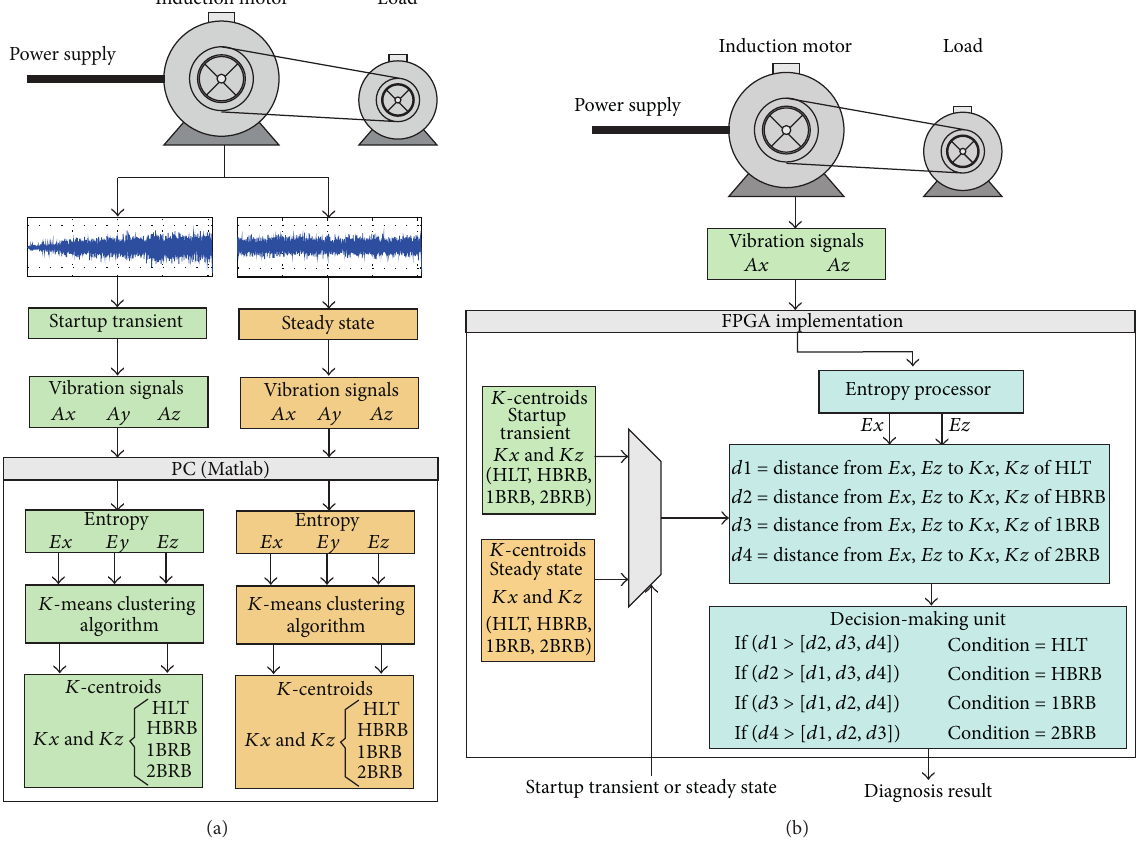
Figure 2: Proposed methodology: (a) design stage and (b) implementation stage. Table 1: Entropy values.